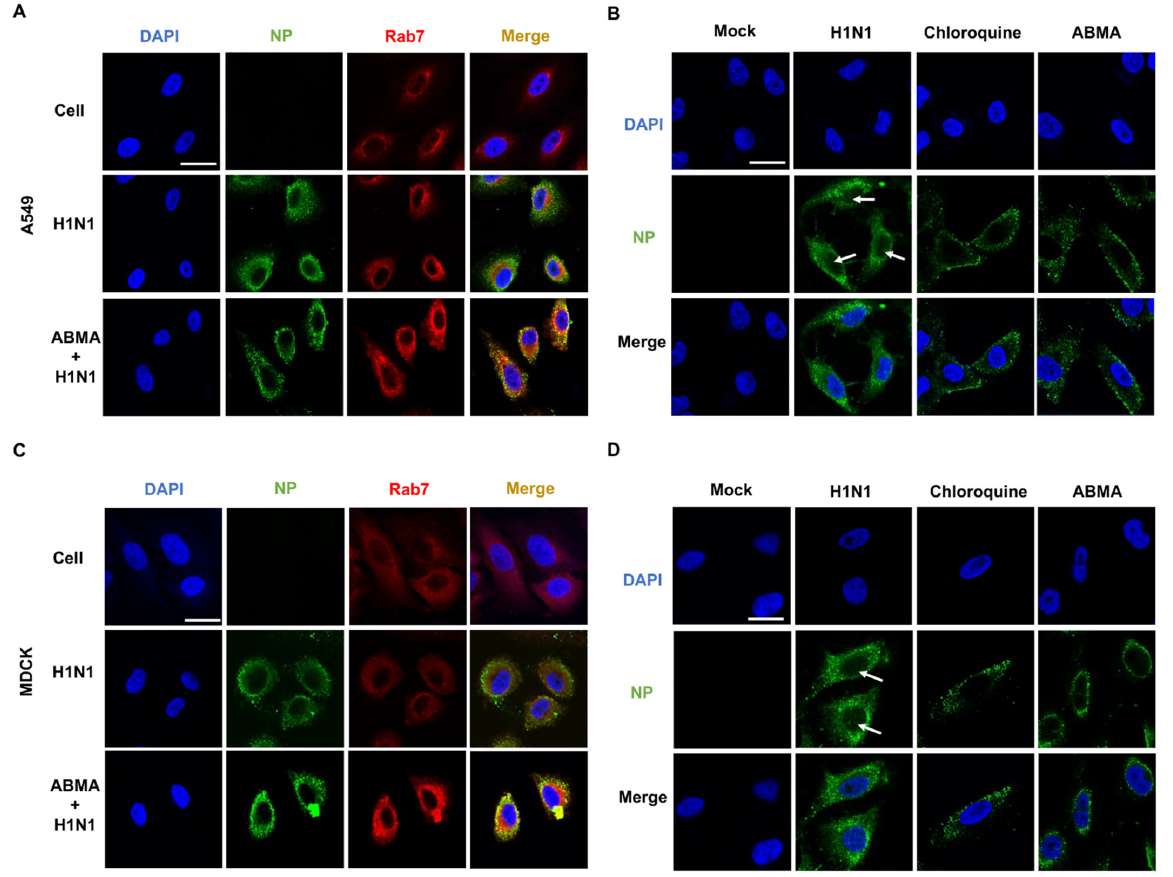
Figure 4. ABMA leads to an accumulation of H1N1 virions in late endosomes. ( A ) A549 cells or ( C ) MDCK cells were pretreated with ABMA (15 µM) for 5 h and infected with A/NY/61/LV16A (H1N1, MOI = 1). At 3 hpi, cells were fixed in 4% paraformaldehyde and incubated with the primary anti- bodies (mouse monoclonal anti-H1N1-NP, rabbit polyclonal anti-Rab7) overnight at 4 °C and incu- bated with the FITC-conjugated goat anti-mouse (green) and Cy5-conjugated goat anti-rabbit (red) secondary antibodies for 1 h at room temperature. ( B ) A549 cells or ( D ) MDCK cells were pretreated with ABMA (15 µM) or chloroquine (15 µM) for 5 h and infected with A/NY/61/LV16A (H1N1, MOI = 1). At 8 hpi, cells were fixed in 4% paraformaldehyde and incubated with the primary antibodies (mouse monoclonal anti-H1N1-NP) overnight at 4 °C and incubated with FITC-conjugated goat anti-mouse (green) secondary antibodies for 1 h at room temperature. The nuclei were stained with DAPI (blue). White arrows: NP in the nucleus. Scale bar: 20 µm.